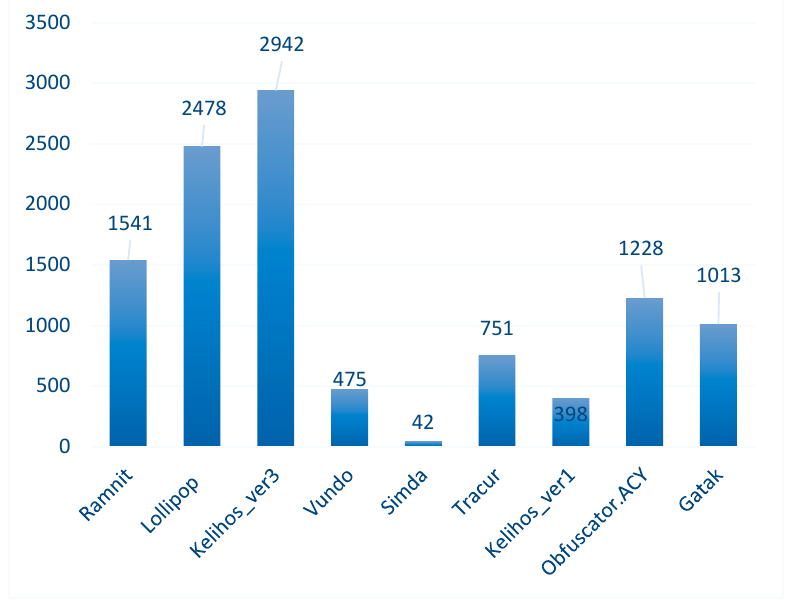
Figure 8. Microsoft malware data set and partition.